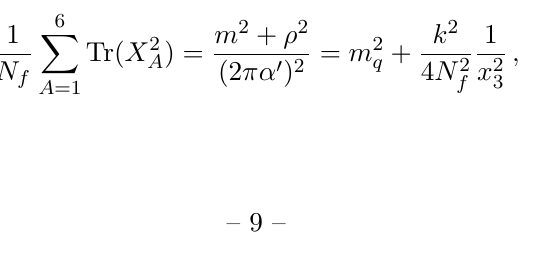
Figure 1. Left side: a plot of massive D5-brane embeddings. The embeddings start as regular D5-brane embeddings at large u and approximate a stack of k D3-brane embeddings for x 3 Right side: a plot of massless D5-brane embeddings. The stack of k D3-branes overlaps with the original stack of D3-branes for x 3 ! (cid:0)1